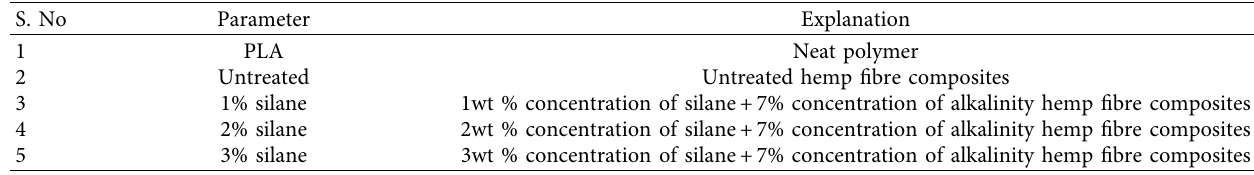
Table 2: Parameters for preparing silane concentrations.